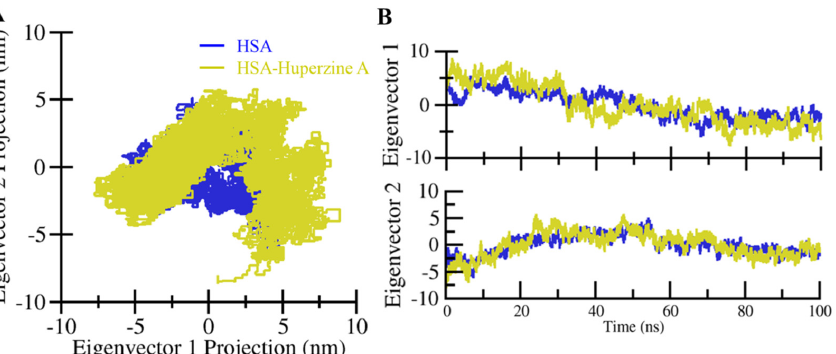
Figure 6. Intermolecular hydrogen bonds during the simulation. ( A ) Time evolution of hydrogen